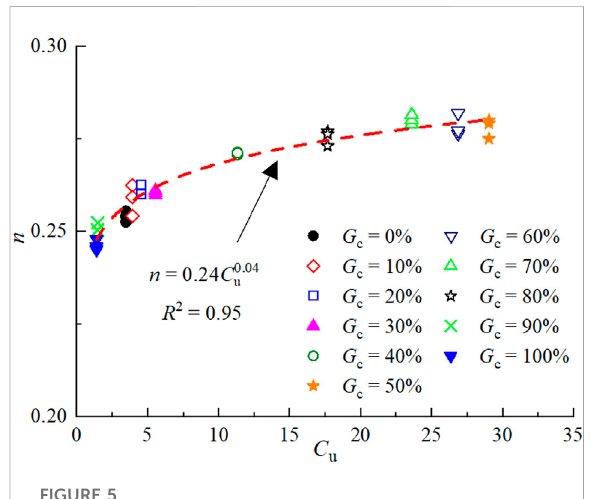
FIGURE 5 Relationship between the fi t coef fi cient n and coef fi cient of uniformity.